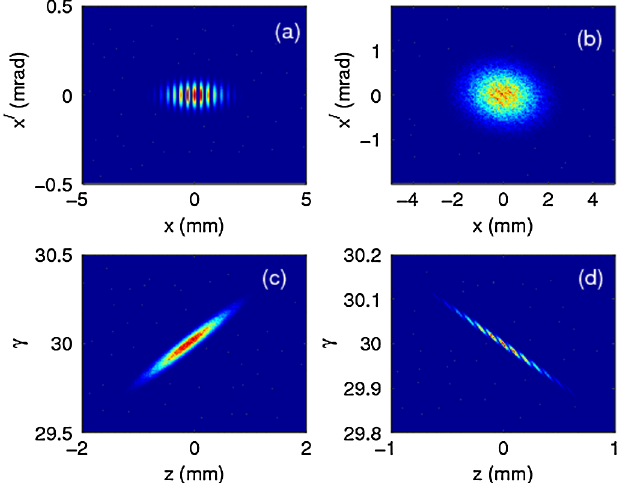
FIG. 5. Example of conversion of a transverse modulation (a) into a modulation on the longitudinal phase space (d). The plots (a) and (c) show the initial horizontal and longitudinal phase space while the plots (b) and (d) show the corresponding final phase spaces downstream of the EEX beam line. The initial Þ ¼ ð 1 ; 10 Þ (cid:14) m ; " n emittance partition is ð " n x; 0 z; 0